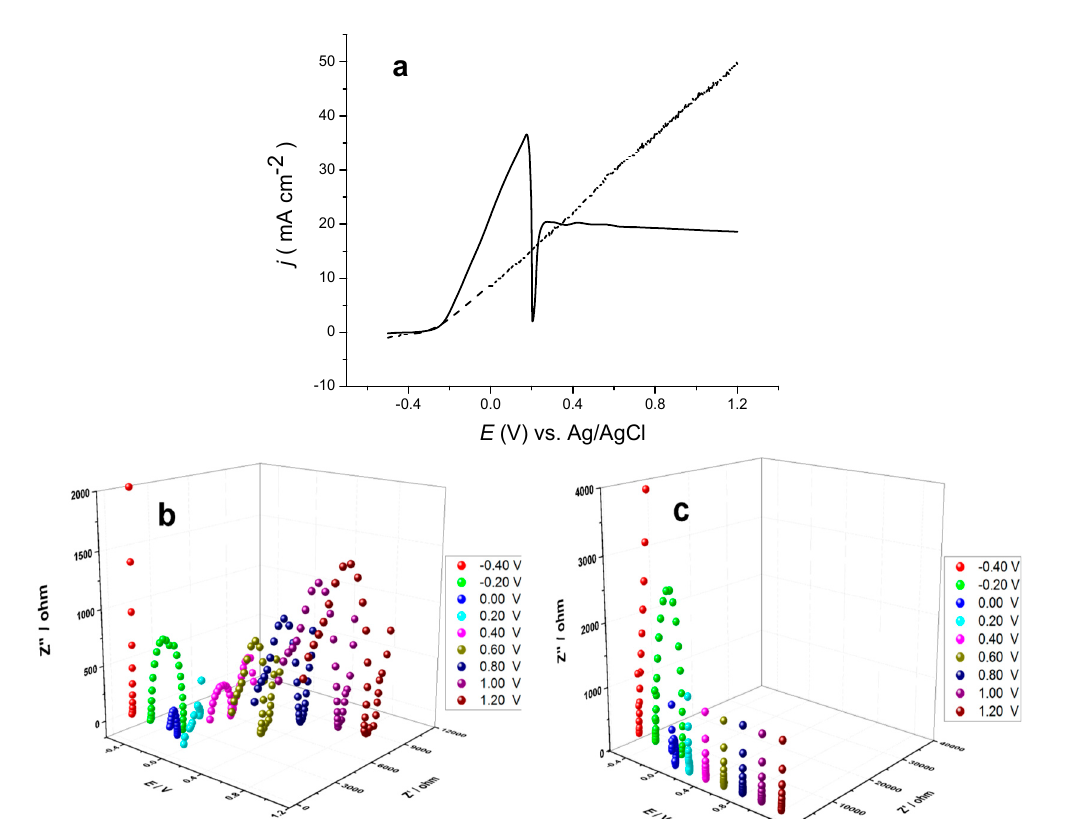
Figure 8. ( a ) Comparative anodic linear sweep voltammograms of a bulk copper in choline chloride-based IL at 20 °C (solid line) and imidazolium-based IL at 70 °C (dashed line) ( b ). Electrochemical impedance spectra of copper in choline chloride-based IL at 20 °C at various potentials with an AC amplitude of 10 mV in the frequency range of 1–65,000 Hz ( c ), as in ( b ) but using imidazolium-based IL at 70 °C.